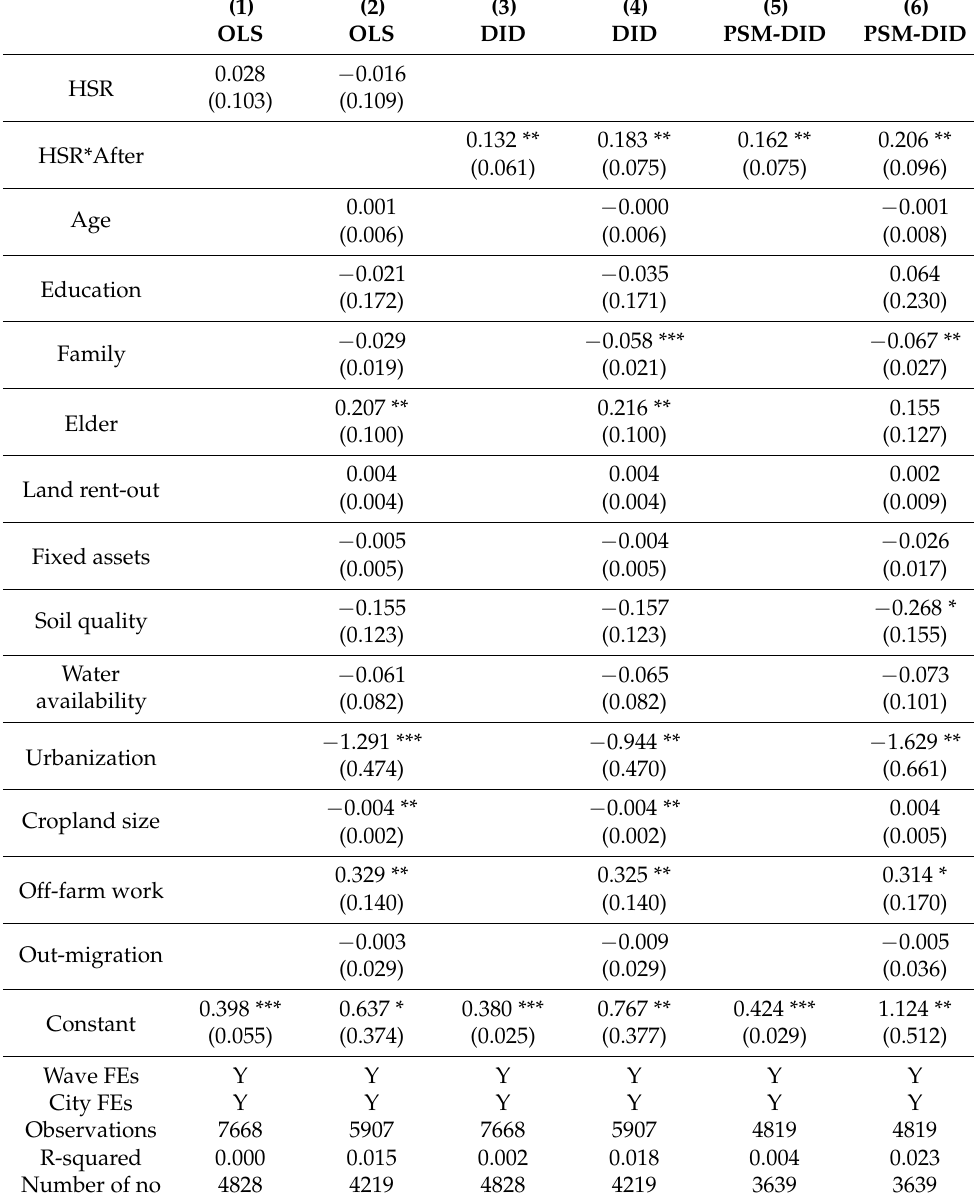
Table 4. OLS, DID, and PSM-DID estimation results for the HSR effect on cropland